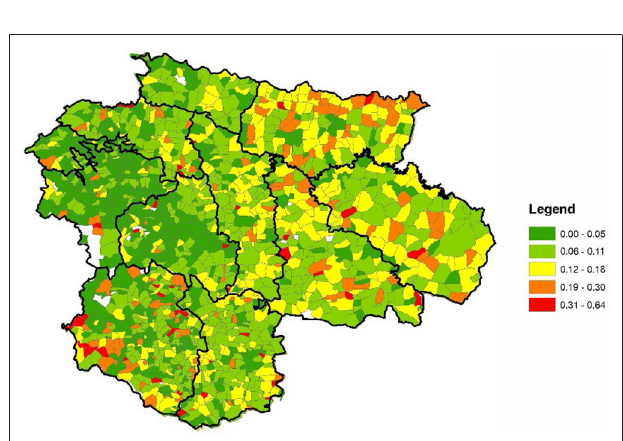
FIGURE 15 | Proportion of the population who are agricultural